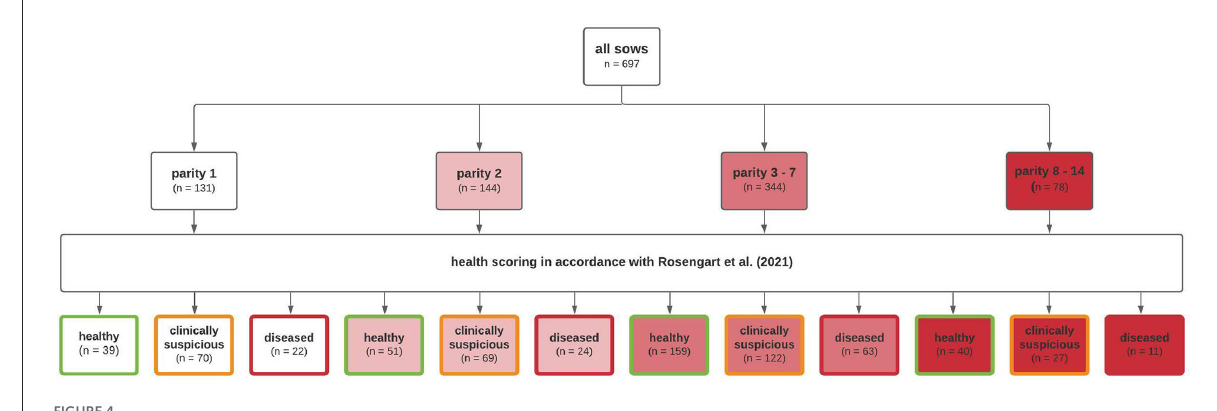
FIGURE4 Schematic diagram showing group categorization of investigated sows.